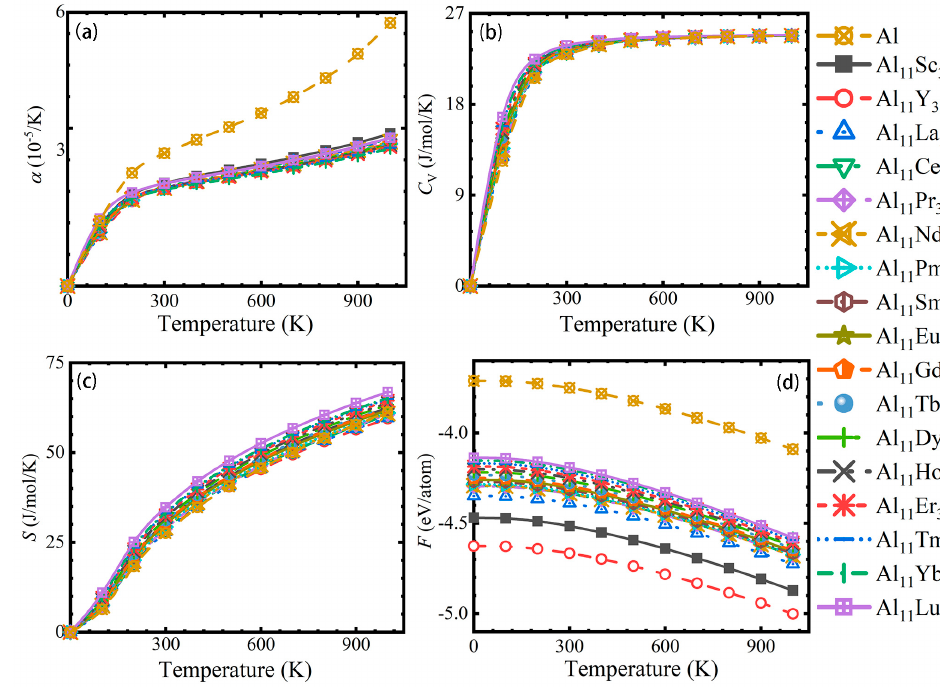
Figure 3. Aluminum and Al 11 RE 3 at T = 0–1000 K, ( a ) thermal expansion coefficient α as a function of temperature T ; ( b ) constant volume specific heat C V ; ( c ) entropy S ; ( d ) Gibbs free energy F .